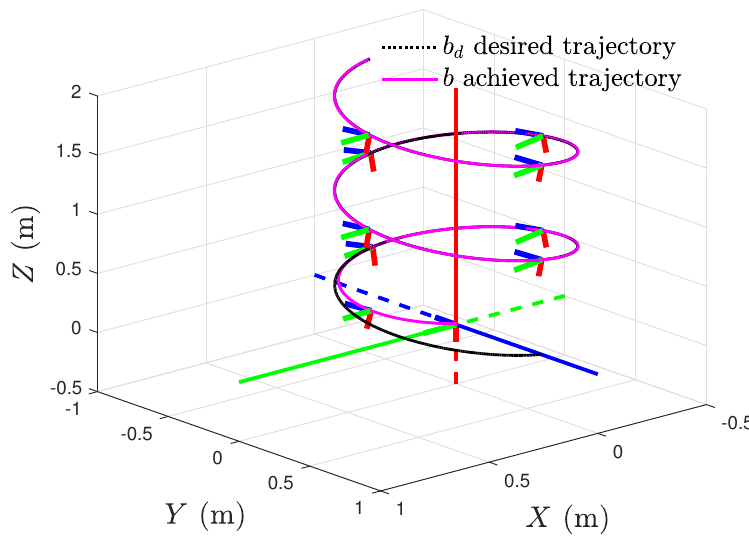
Figure 3. 3D position and attitude